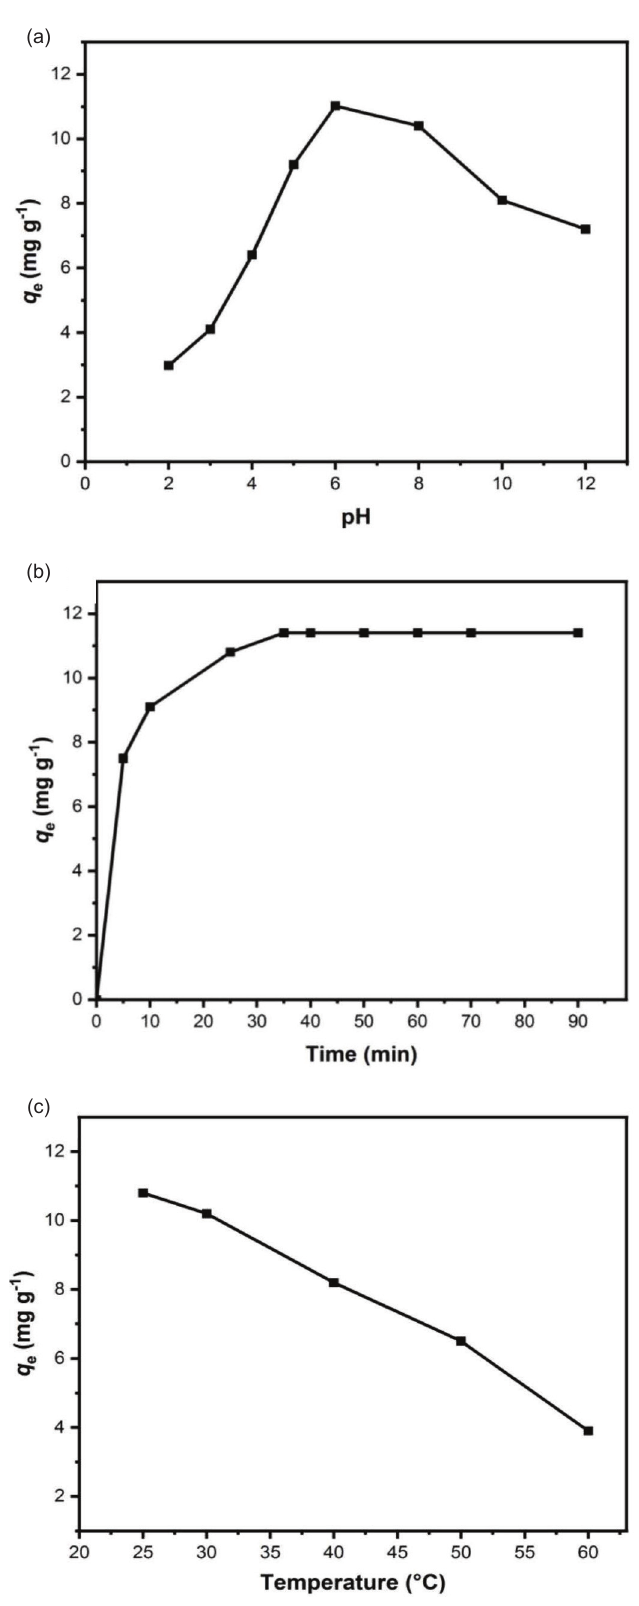
Fig. 2 – Effect of (a) pH; (b) contact time, and (c) tempera- ture on the adsorption of SR 3BL by oxalis (experimental con- ditions: adsorbent dose 1 g L −1 , pH 6, initial dye